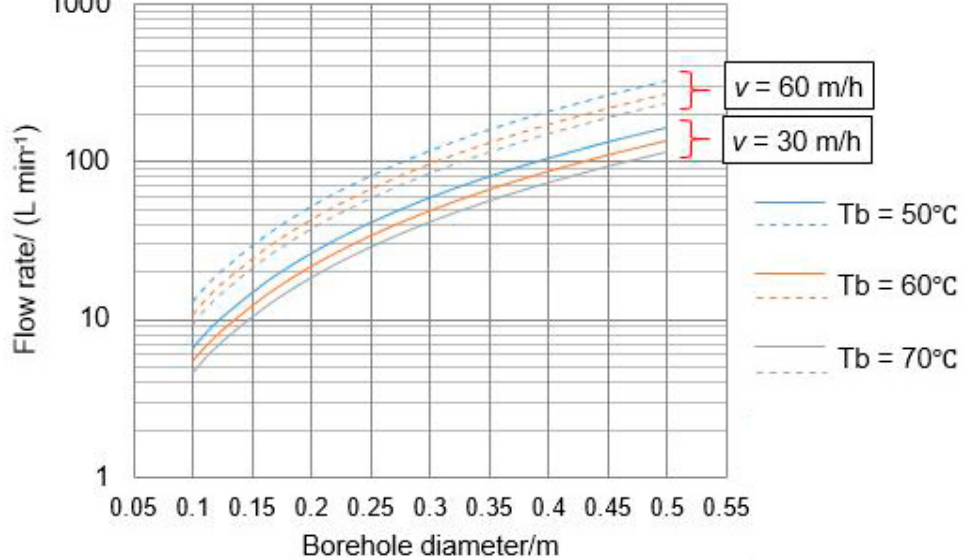
Figure 4. Minimum flow rate vs. average borehole diameter at rate of penetrations (ROPs) of 30 m h − 1 ( a ) and 60 m h − 1 ( b ) and different bottom temperature of drilling water T b .